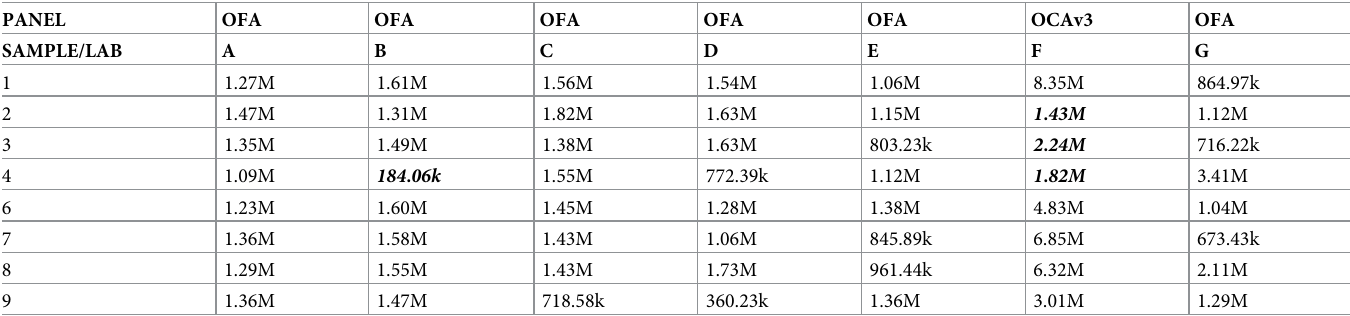
Table 8. Phase 2 DNA mapped read values.